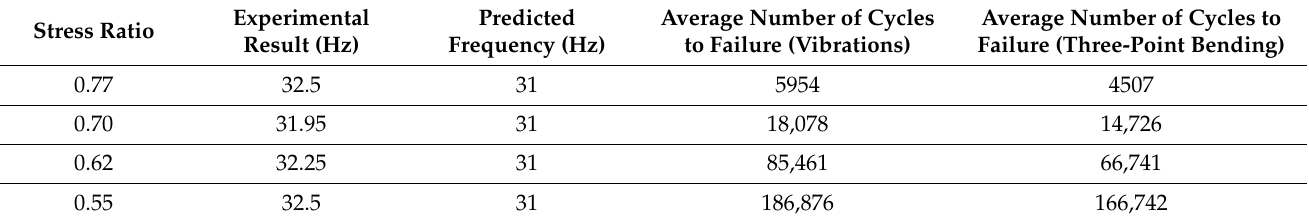
Table 2. Experimental results from Vibration and Three-Point Bending tests.